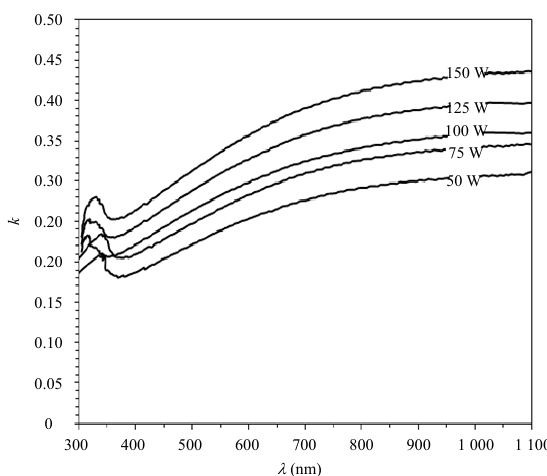
Fig. 6 Extinction coefficient as a function of wavelength for (Ti6Al4V) thin film at different working RF powers.